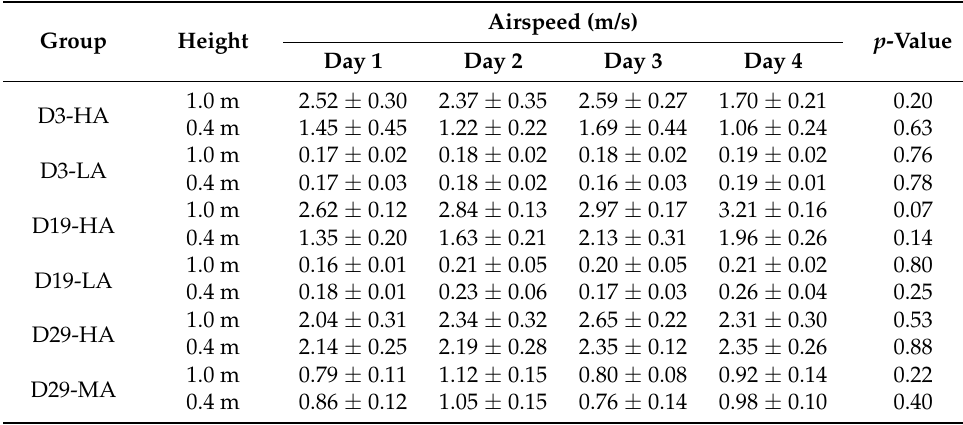
Table 3. Airspeeds (mean ± SEM) in calf